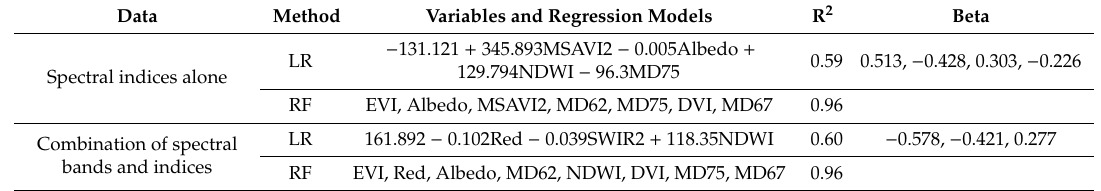
Table 5. Comparison of modeling e ff ects between di ff erent algorithms and among di ff erent